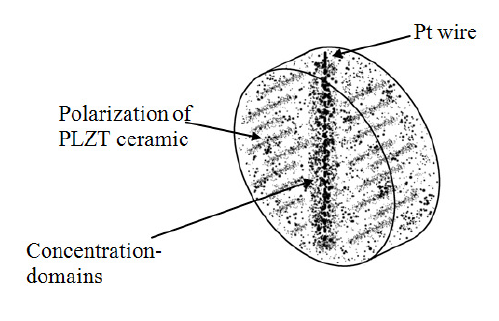
Figure 2. Scheme of the CCP and its domains distributed around the